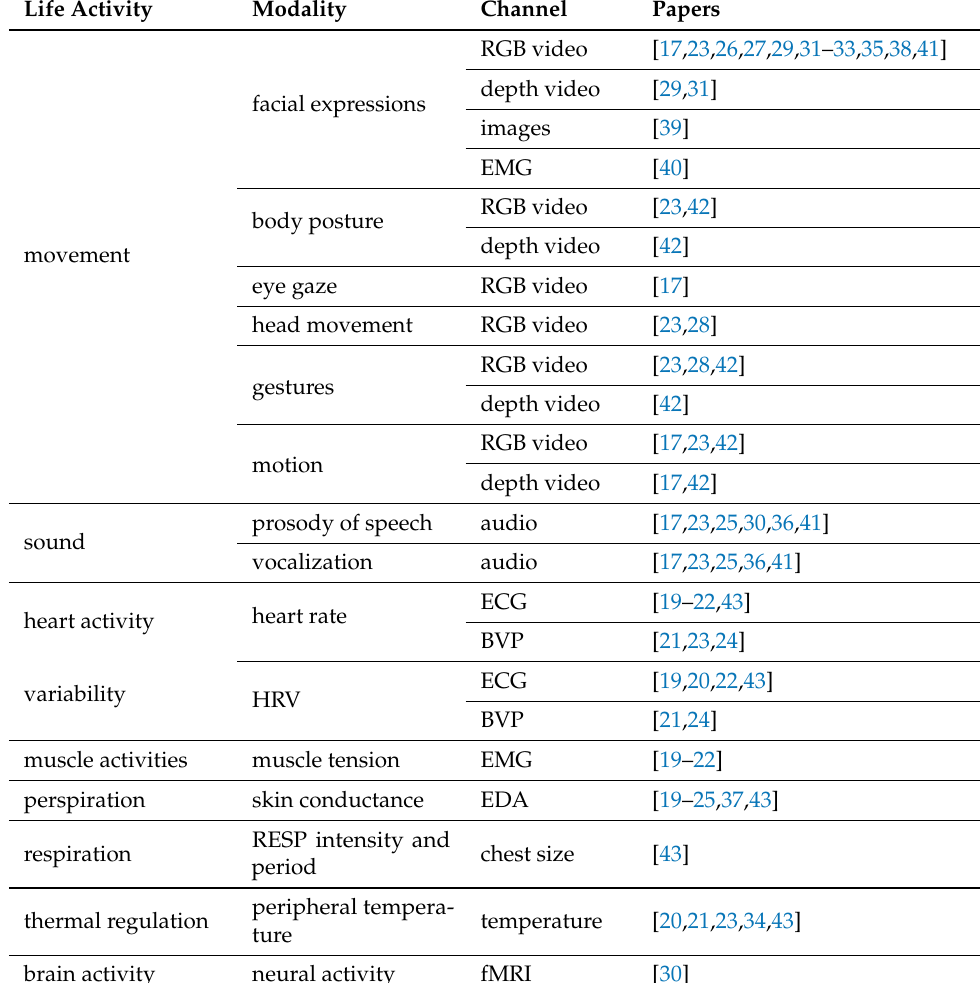
Table 5. Studies corresponding to channels used in the process of emotion